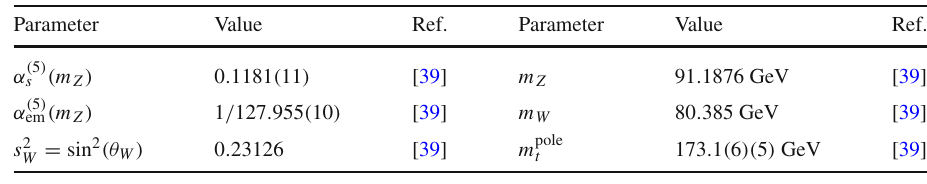
Table 7 The (cid:9) S = 1 Wilson coefficients at various scales